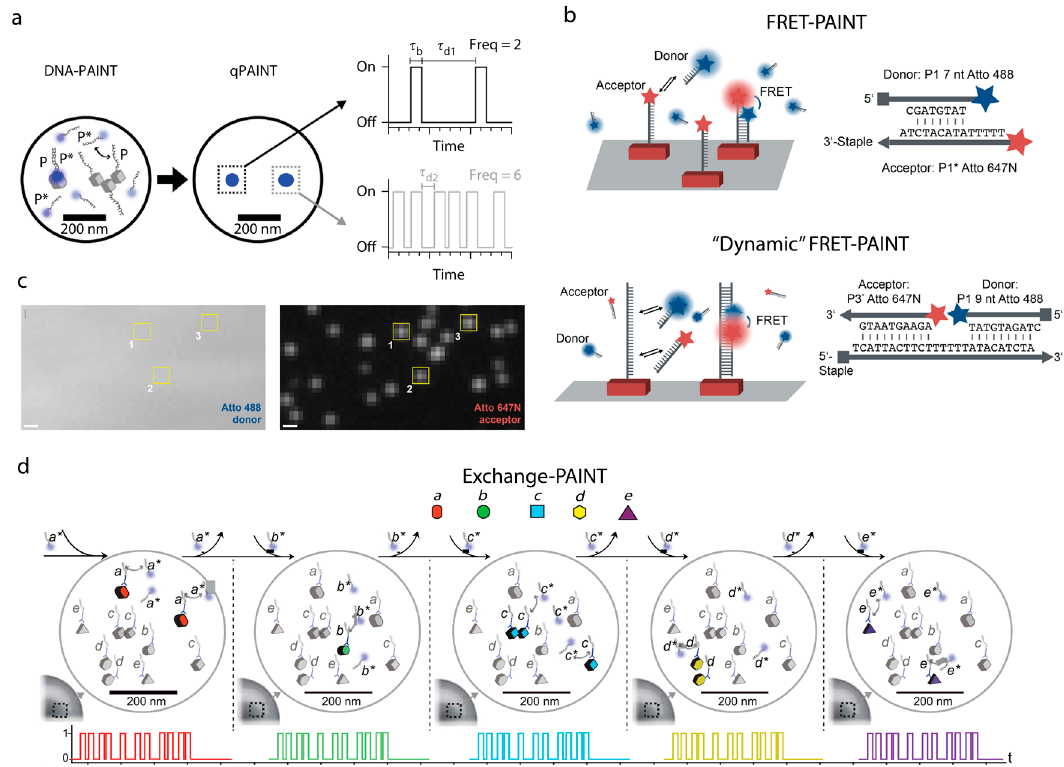
Figure 4. Extended applications of DNA-PAINT. ( a ) qPAINT. Two different complexes unresolvable by DNA-PAINT imaging with one or three docking strands. The two complexes, owing to the predictable binding of the imager strand to the docking strand, have characteristic blinking traces, with the complex possessing 3 docking strands having an increased frequency of binding events. By observing the time between events the number of docking strands can be determined from such traces given a single docking site calibration. Image adapted from [37]. ( b ) Fluorescence resonance energy transfer (FRET)-PAINT relies on bringing imager DNA with a donor fluorophore into proximity with DNA possessing an acceptor fluorophore. There are two routes for such imaging, one where the acceptor is fixed to the docking strand (top) and another where both the acceptor and donor are free